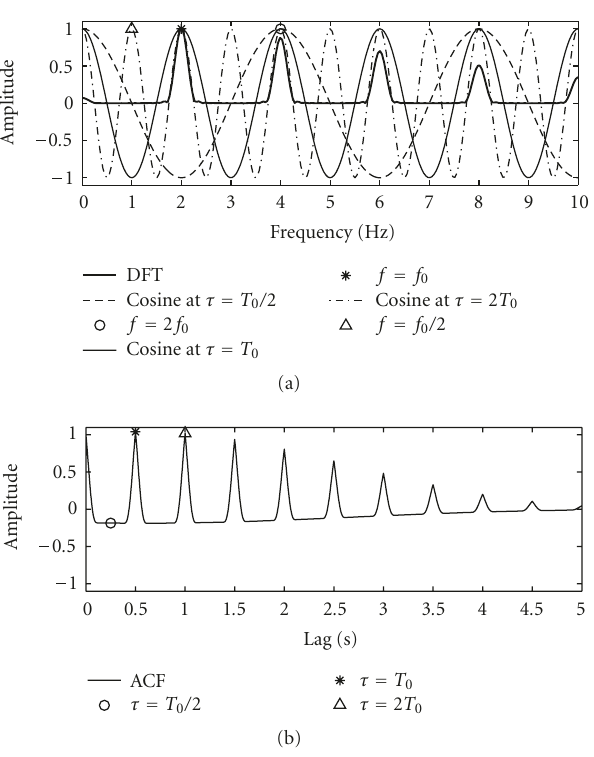
Figure 5: (a) magnitude of the DFT of the signal; superimposed: cosine at τ = T 0 / 2, T 0 , 2 T 0 and f = 2 f 0 , f 0 , f 0 / 2 positions; (b) au- tocorrelation function; superimposed: τ = T 0 / 2, T 0 , 2 T 0 positions; on [signal: periodic impulse signal at 2 Hz].